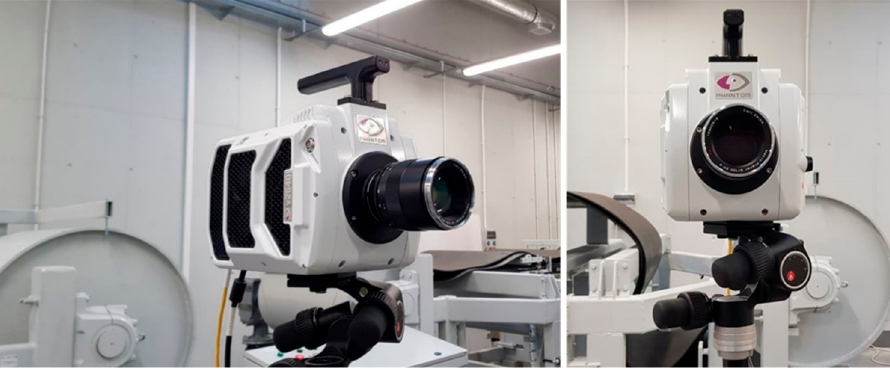
Figure 9. View of the Phantom v2640 camera at the measurement location.